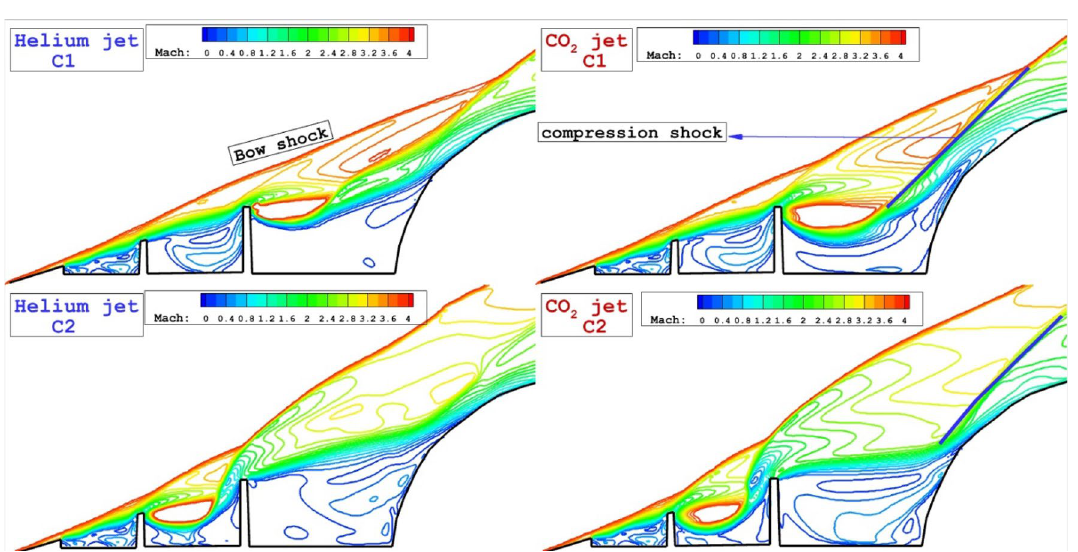
Figure 5. Comparison of Mach contour for the injection system from the tip of